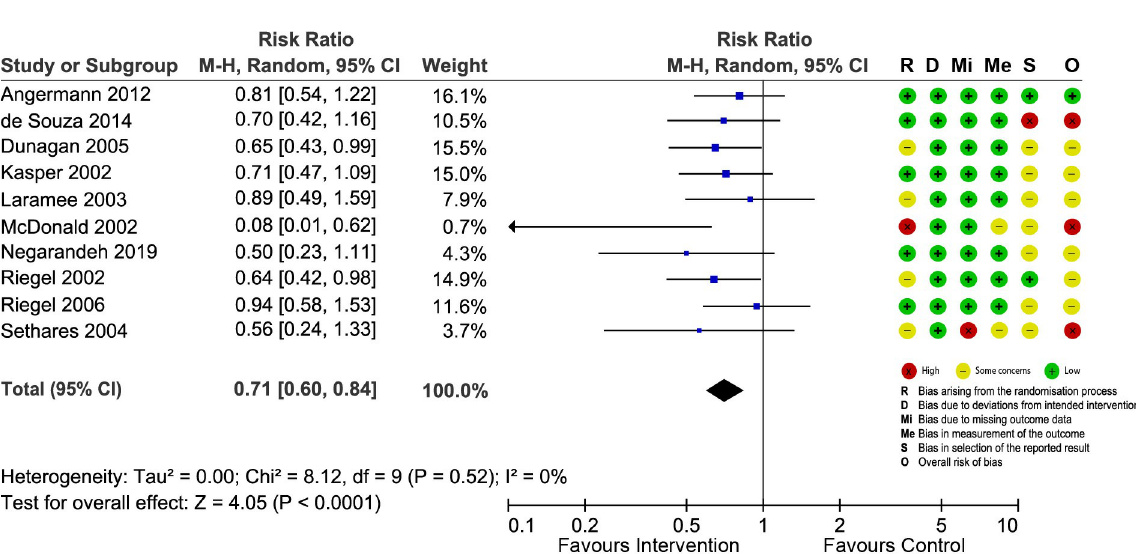
PLOS ONE | https://doi.org/10.1371/journal.pone.0261300 December16,